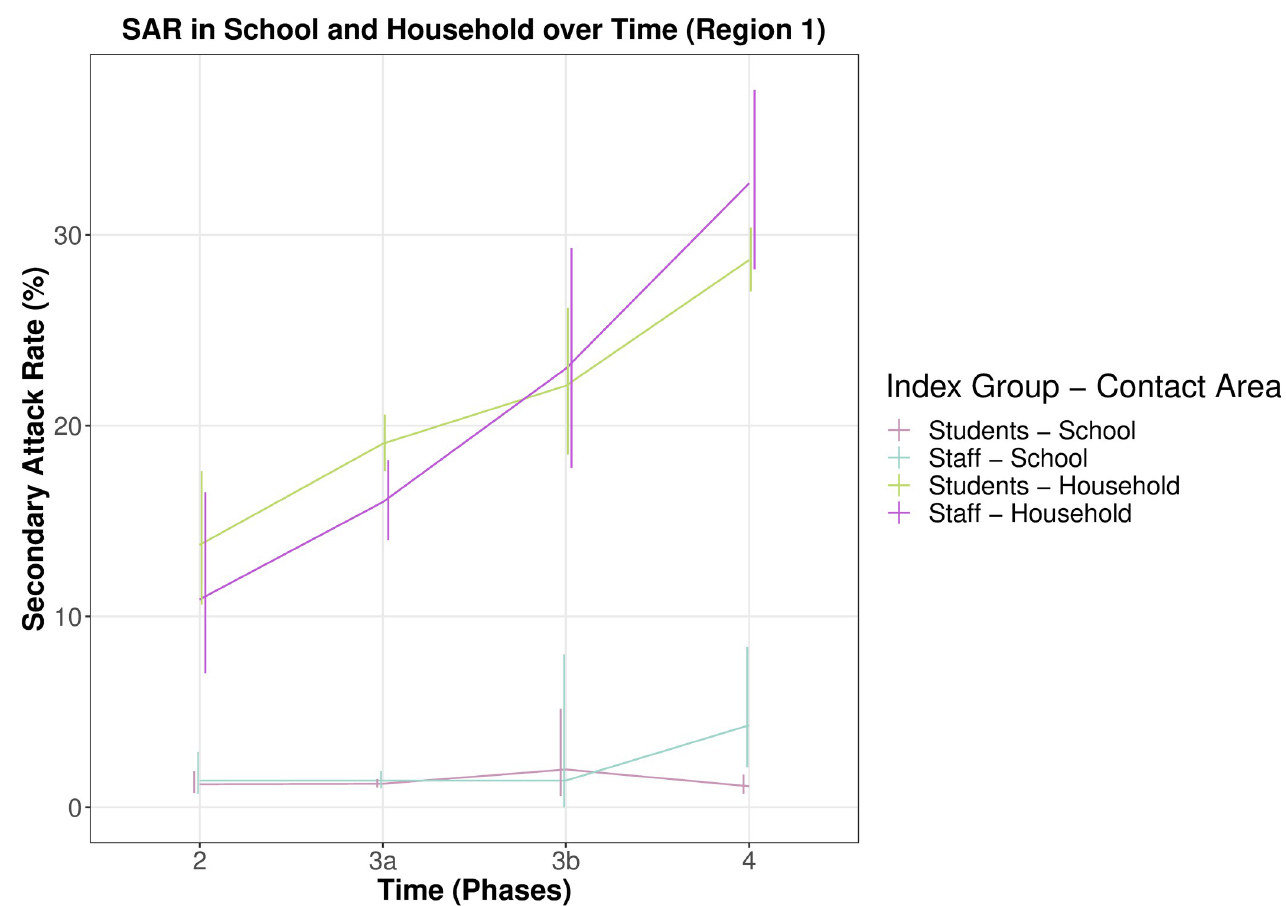
Fig 5. School and household SAR in students and staff over time. Comparison of school and household specific SARs for students and staff for Region 1. Vertical lines represent 95% CIs. Phase 2 summer plateau 2020, phase 3a second wave with open schools, phase 3b second wave with school closures, phase 4 mixed class models and VOC alpha. CI, confidence interval; SAR, secondary attack rate; VOC, variant of concern.